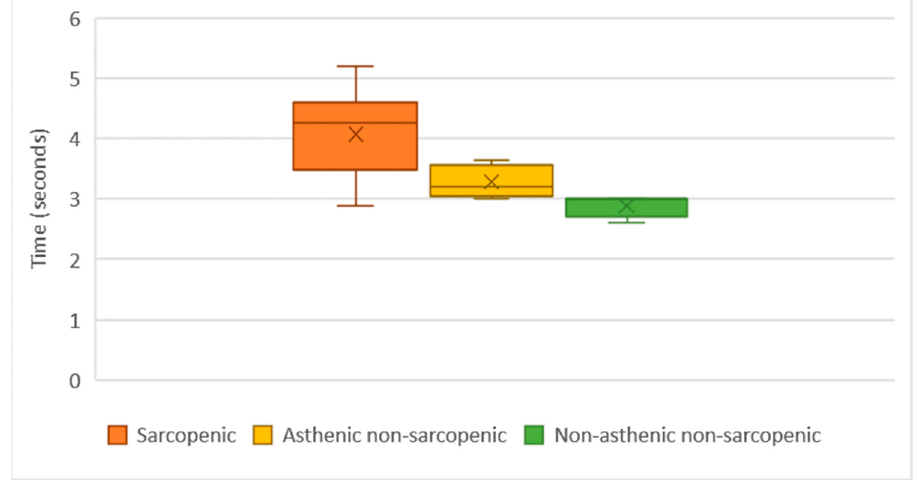
Figure 6. Walking time of the three patient groups: sarcopenic (orange), asthenic non-sarcopenic (yellow) and non-asthenic non-sarcopenic (green).